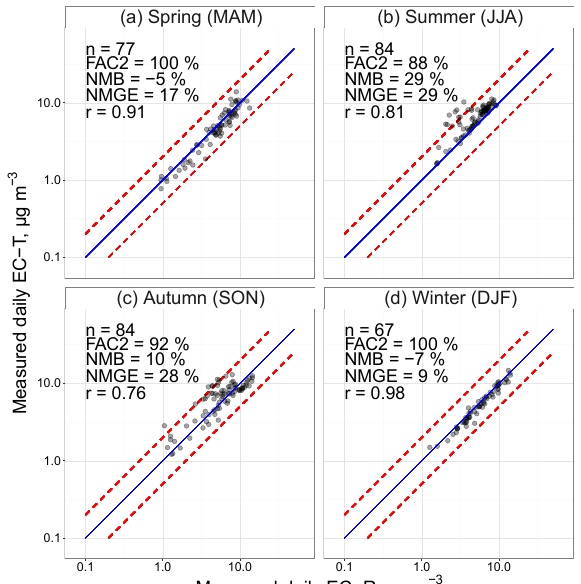
Figure A4. Scatter plot of measured daily average EC split from TC using reflectance (EC-R) against EC split from TC using transmittance (EC-T) at the Marylebone Road site split by seasons, year